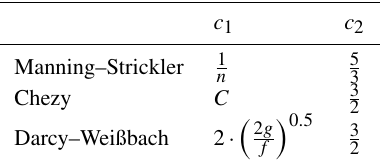
Table 1. Coefficients of general friction law.